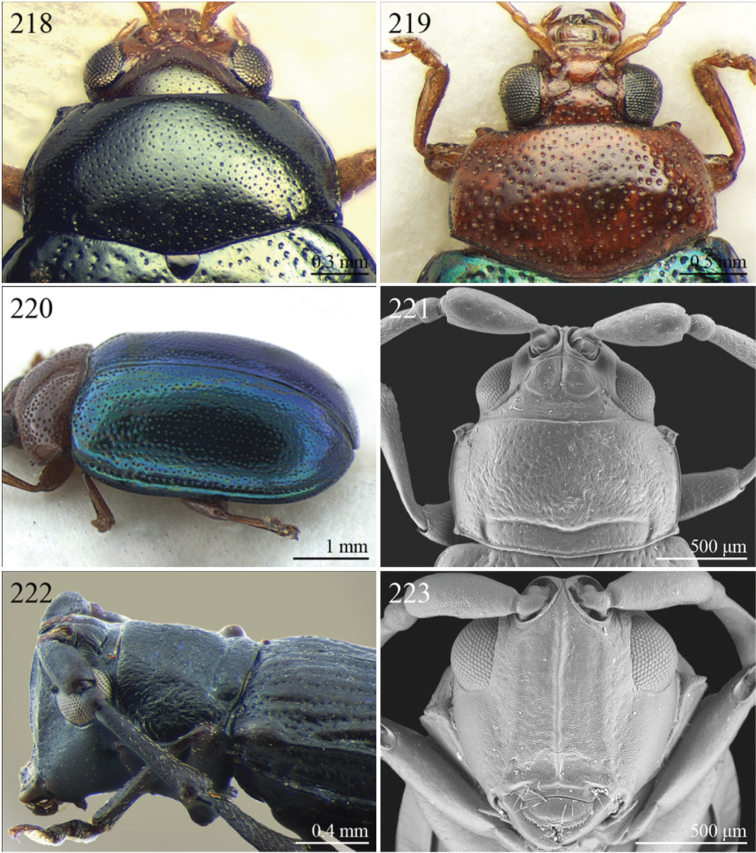
Morphological characters. 218
Nisotra sp., head and pronotum in dorsal view 219 Notomela viridipennis Bryant, head and pronotum in dorsal view 220 Ditto, elytra in lateral view 221
Ntaolaltica antennata Biondi & D’Alessandro, head and pronotum in dorsal view 222 Ditto, head and pronotum in lateral view 223 Ditto, head in frontal view.